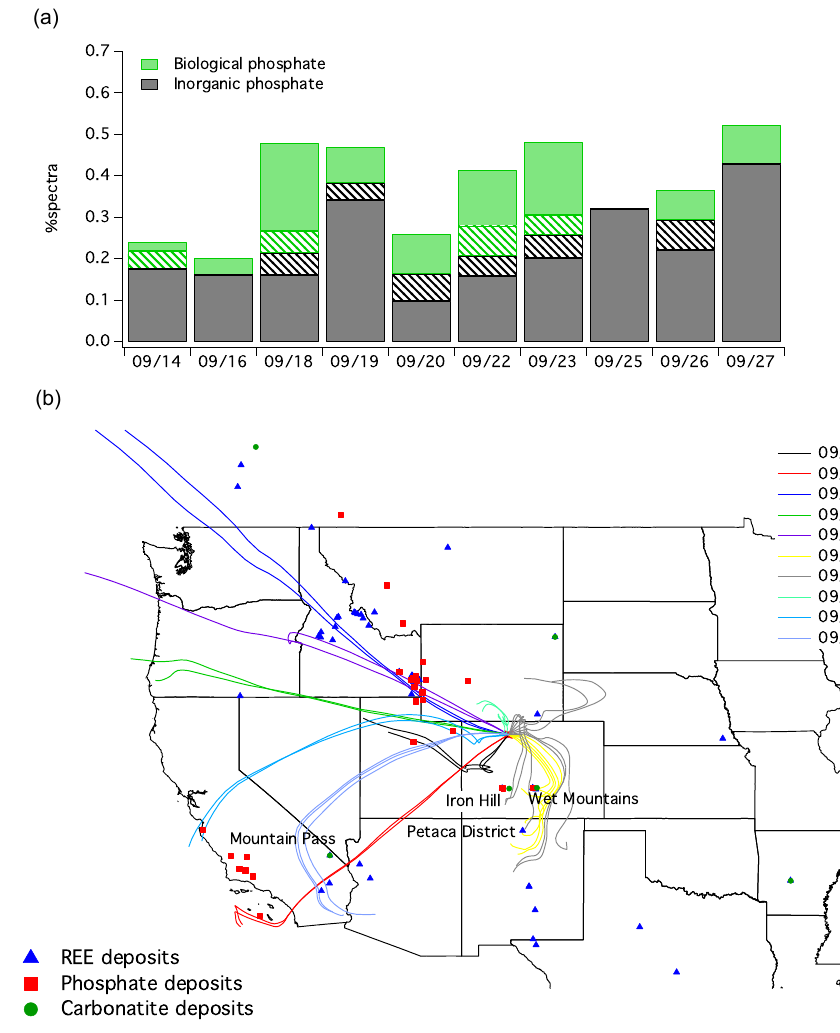
Figure 6. (a) The percentage of ambient aerosol particles from the FIN03 dataset categorized as biological and inorganic (phosphate-bearing mineral dust or fly ash) phosphate using the criteria developed in this work. Hatched regions indicate uncertain assignments as per the boundaries in Fig. 5. Note that at this location and time of year inorganic phosphate dominates biological particles. (b) HYSPLIT back trajectories plotted for 10 measurement days at Storm Peak Laboratory. Locations of REE, phosphate and carobonatite deposits, sourced from US Geological Survey, are co-plotted (Berger et al., 2009; Chernoff and Orris, 2002; Orris and Grauch, 2002). Dates are given as